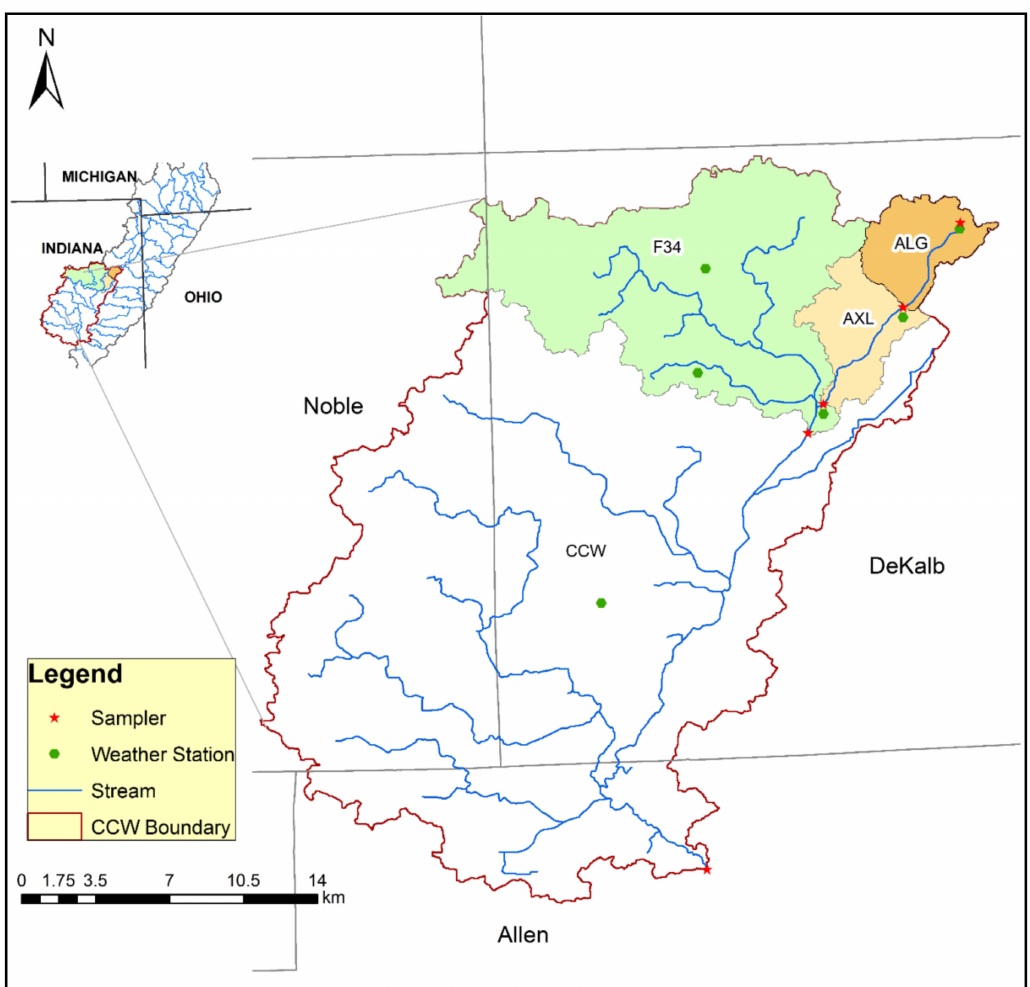
Figure 1. Location map of the study watersheds (CCW, F34, AXL, and ALG) in Northeast Indiana with respect to the entire St. Joseph River Watershed